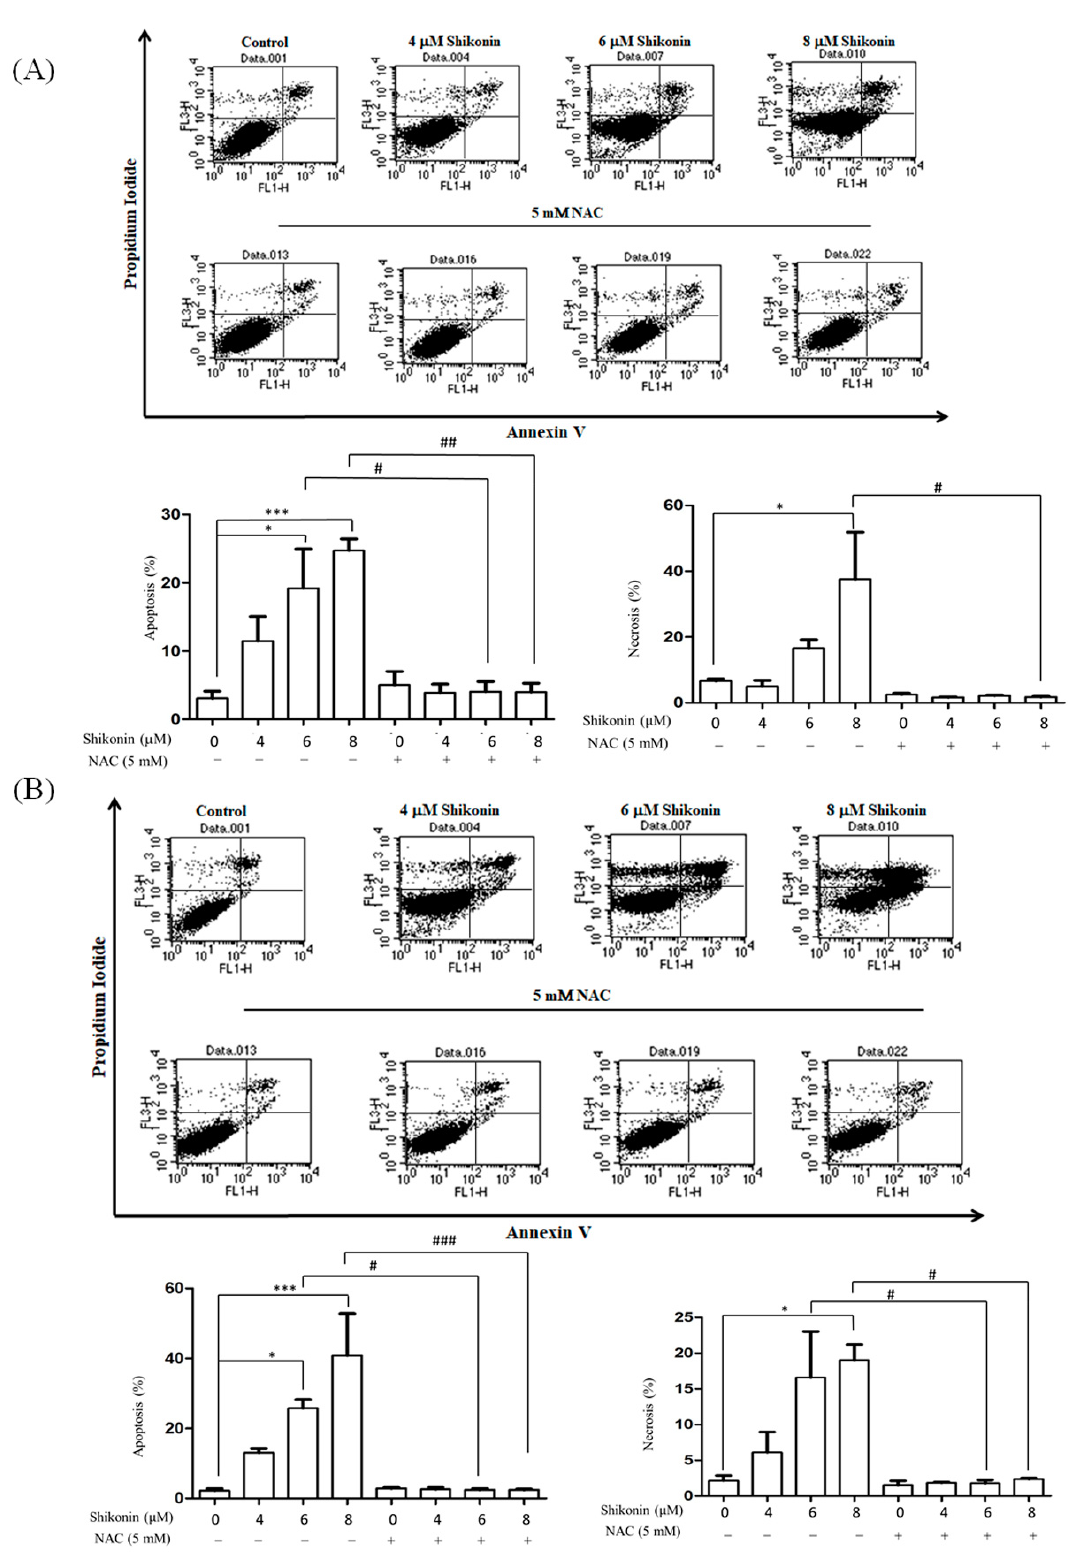
Figure 2. Shikonin induced apoptosis and necrosis in RCC cells. PI/annexin V double staining of ( A ) ACHN and ( B ) Caki-1 cells treated with shikonin for 24 h with or without pretreatment with NAC. Data represent means ± standard deviation from at least three independent experiences. * p < 0.05 and *** p < 0.001 compared with the control group. # p < 0.05, ## p < 0.01, and ### p < 0.001 compared with the NAC pretreated group.